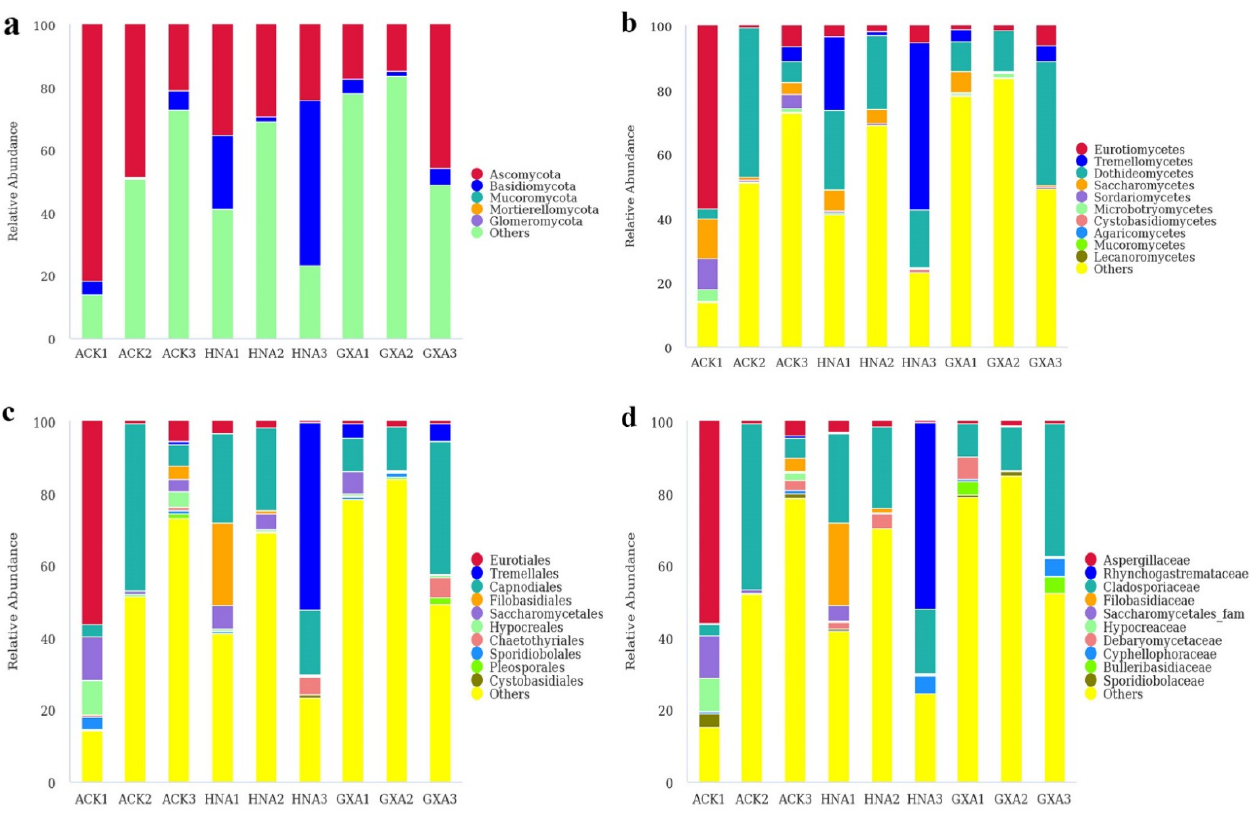
Figure 4. Fungal composition of the AOF samples at the phylum ( a ), class ( b ), order ( c ), and family ( d ) levels.